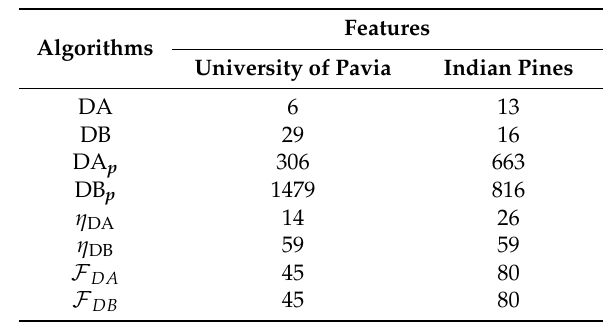
Table 5. The number of features used for classification in the proposed method and the corresponding AUTOMATIC approaches in the two test cases.